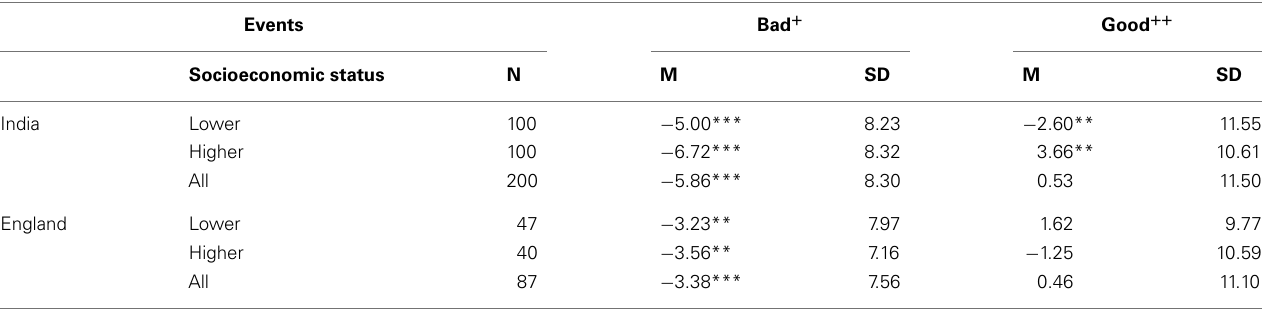
Table 1 | Participants’ average estimates of the chances of events happening in their own lives in comparison to the chances of those events happening in the lives of people like